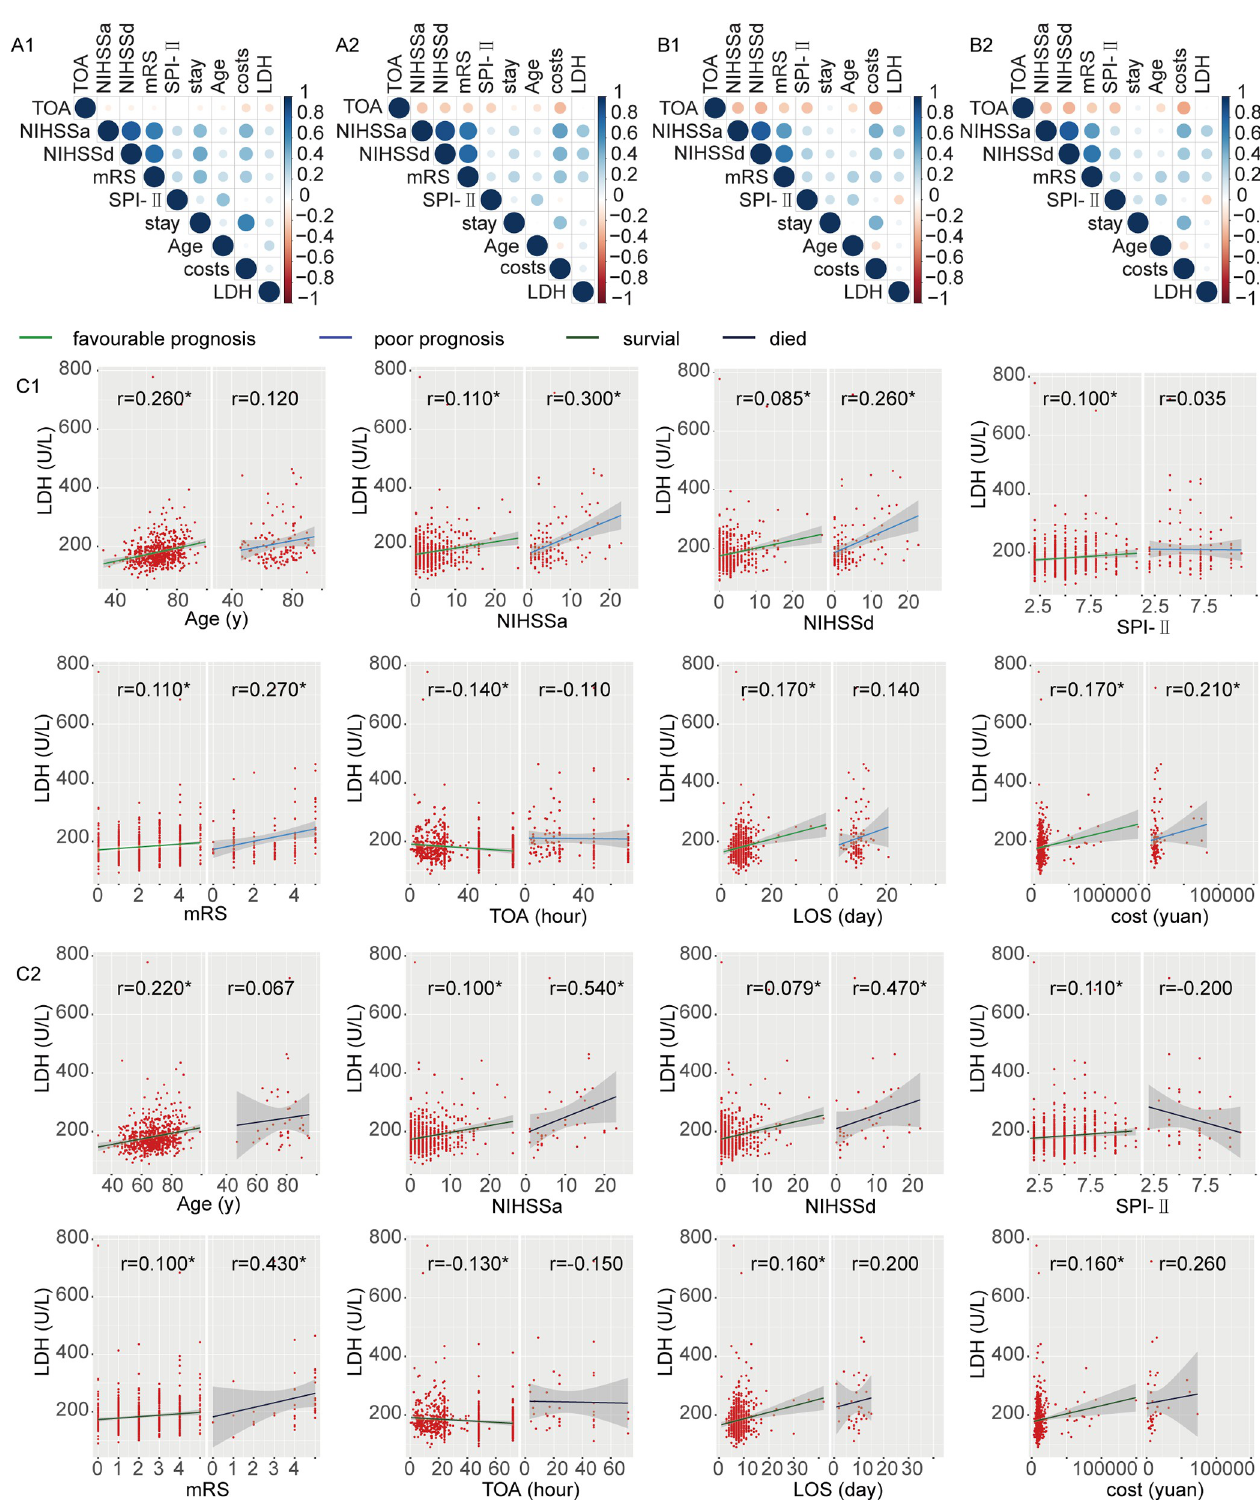
Fig 4. Correlation of LDH with clinical characteristics in AIS patients. A1. Correlation of LDH with clinical characteristics in AIS patients with favourable prognosis; A2. Correlation of LDH with clinical characteristics in AIS patients with poor prognosis; B1. Correlation of LDH with clinical characteristics in survival AIS patients; B2. Correlation of LDH with clinical characteristics in died AIS patients; C1. Comparison of the correlation of LDH and clinical characteristics between AIS patients with favourable prognosis and poor prognosis; C2. Comparison of the correlation of LDH and clinical characteristics